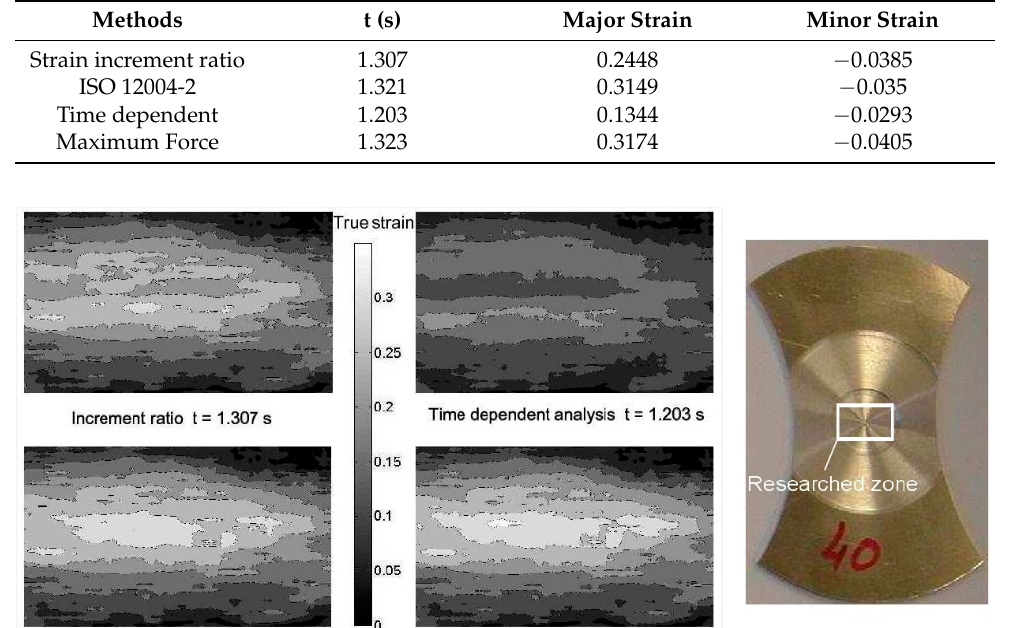
Table 3. Major and minor strains and corresponding times with different methods.